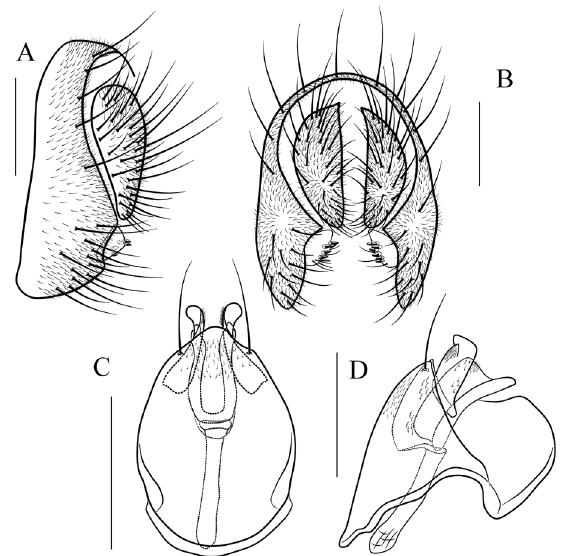
Figure 14. Scaptodrosophila nigripecta sp. n. A, B epandrium, surstylus and cercus (lateral and posterior views) C, D hypandrium, parameres, gonopods, aedeagus and aedeagal apodeme (ventral and lateral views). Scale bars 0.1 mm.